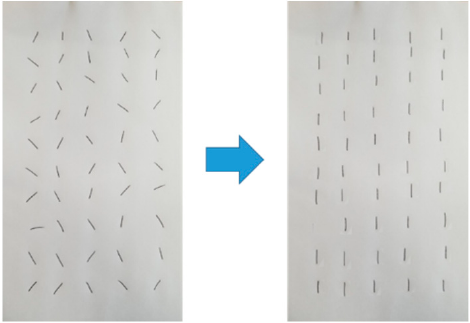
Figure 14. Tilt correction examples of “1” following the proposal ( left : original, right : tilt correction results).